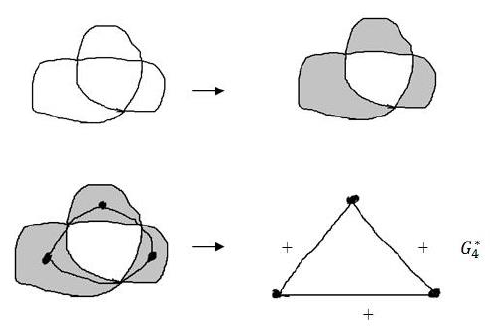
Fig. 3 The graph signed with (+) of K ∗